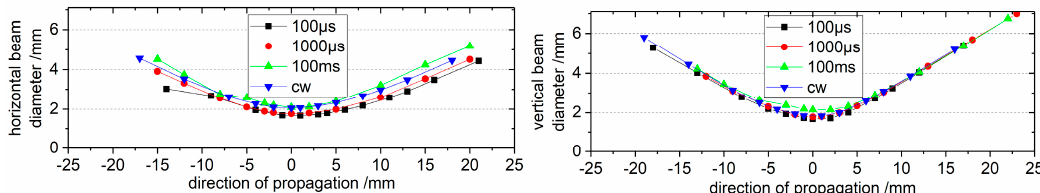
Figure 3. Measured beam diameter as a function of position along the optical (z) axis around the focal plane (caustic) from which the beam quality factor M 2 was derived (fit not shown). Measurements were performed at drive current of 140 A for 100 µs, 1000 µs and 100 ms test and 80 A for cw with heat sink temperature of 17 °C. Table 2. Beam quality factor M 2 for the pump module for various pulse widths and cw in horizontal and vertical direction, obtained from fitting to the data in Figure 3.